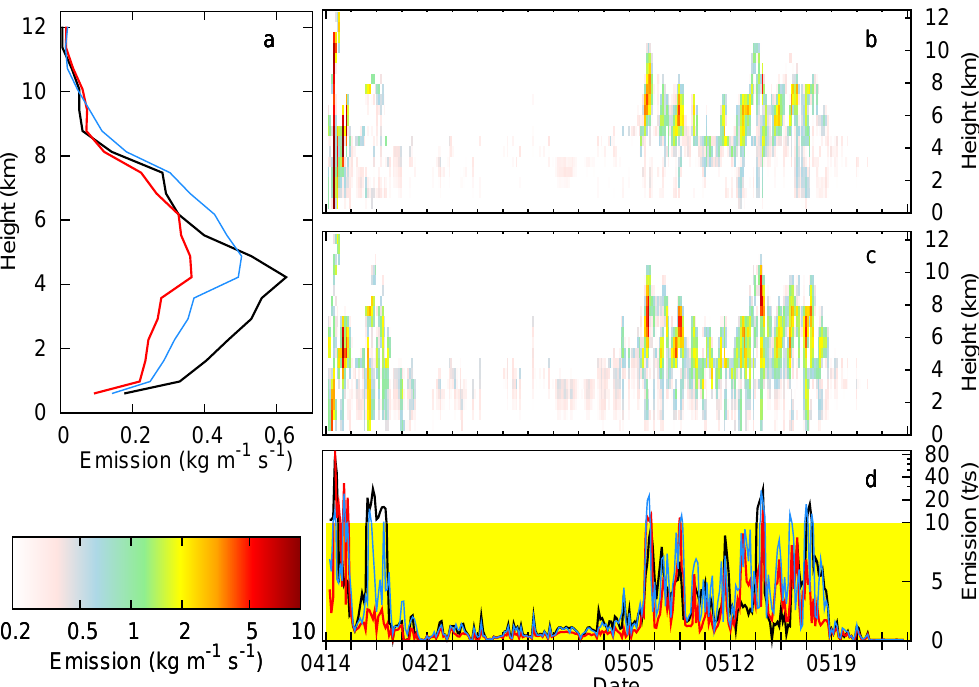
Fig. 5. Sensitivity to input data set. (a) Comparison of temporally-averaged vertical profiles of ash emissions used a priori (black line) and obtained a posteriori by the ECMWF-based inversion when using SEVIRI data only (red line) and when using IASI data only (blue line). (b) A posteriori emissions as a function of altitude and time when using SEVIRI data only. (c) A posteriori emissions as a function of altitude and time when using IASI data only. (d) Vertically integrated a priori (black line) and a posteriori emissions when using SEVIRI data (red line) or IASI data only (blue line), as a function of time.